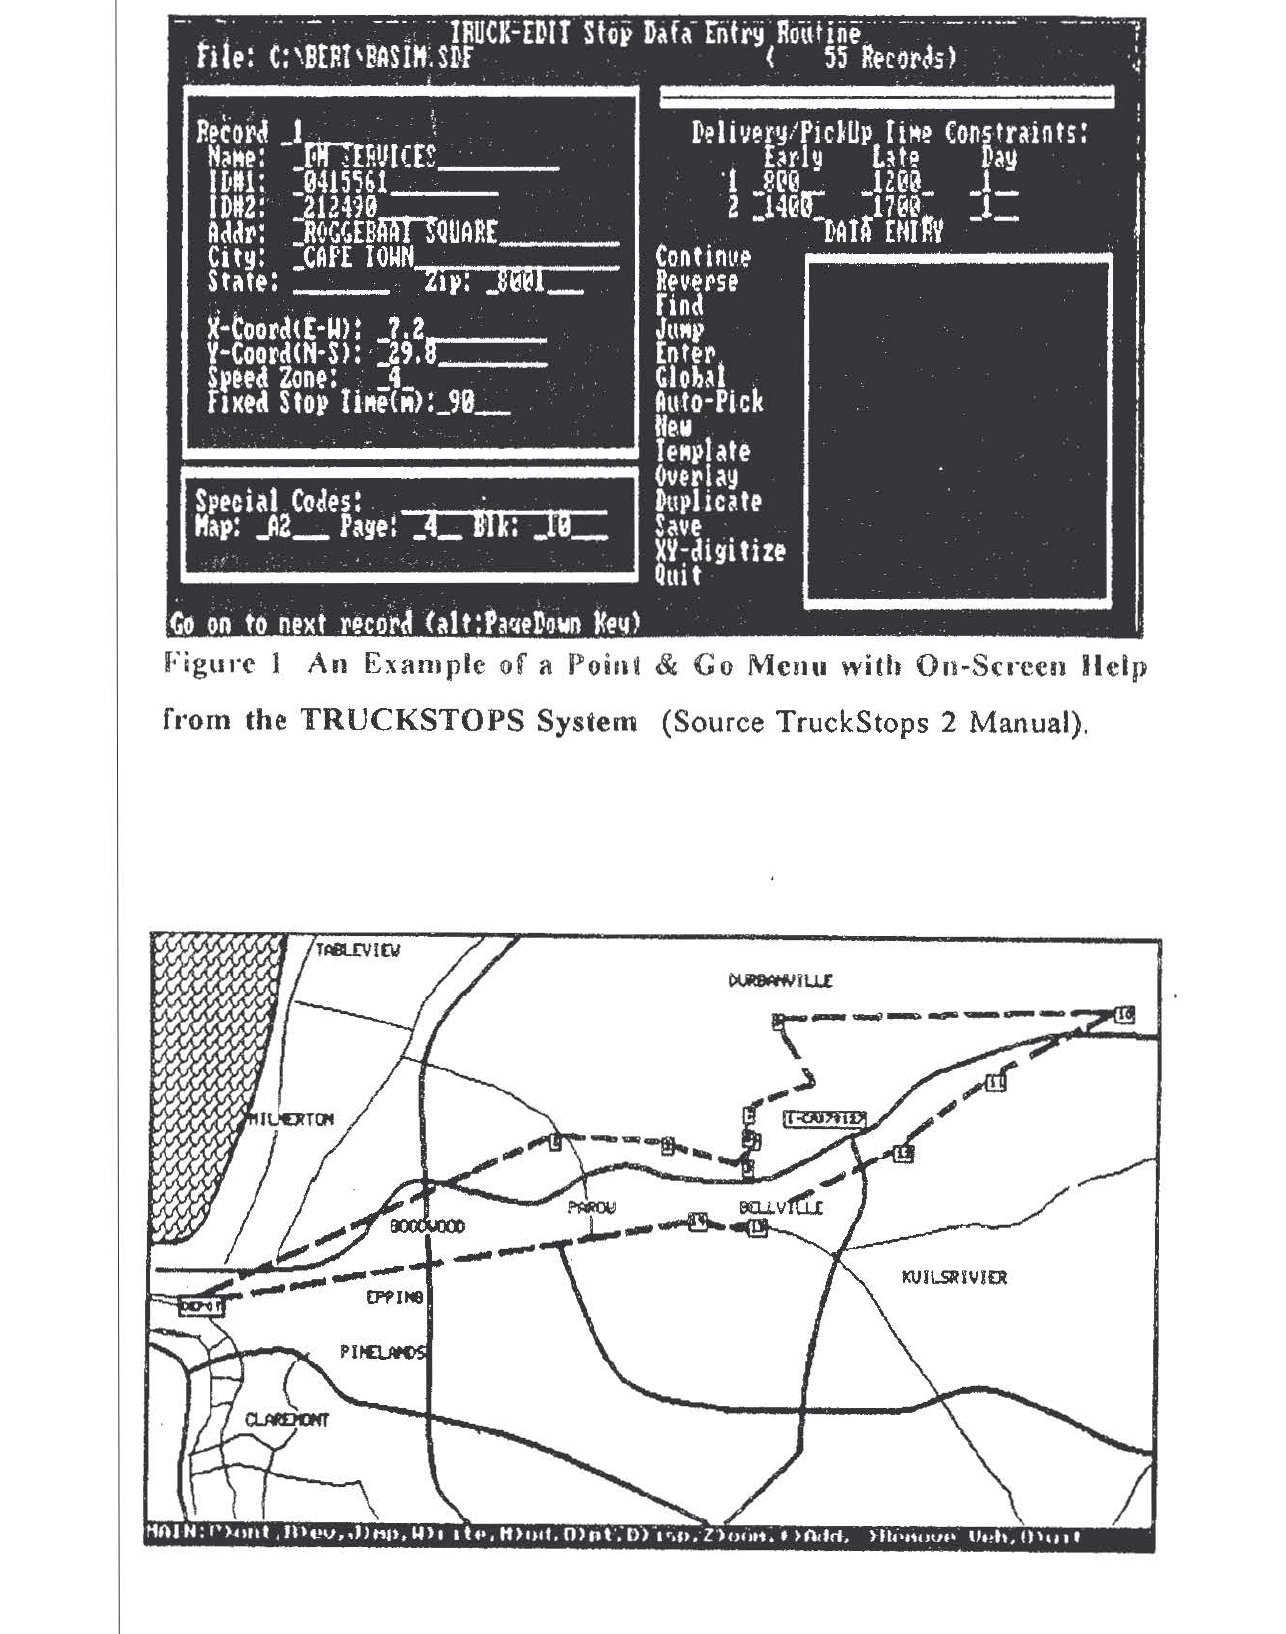
Figure 2 A Typical Route Map (Source: TruckStops 2